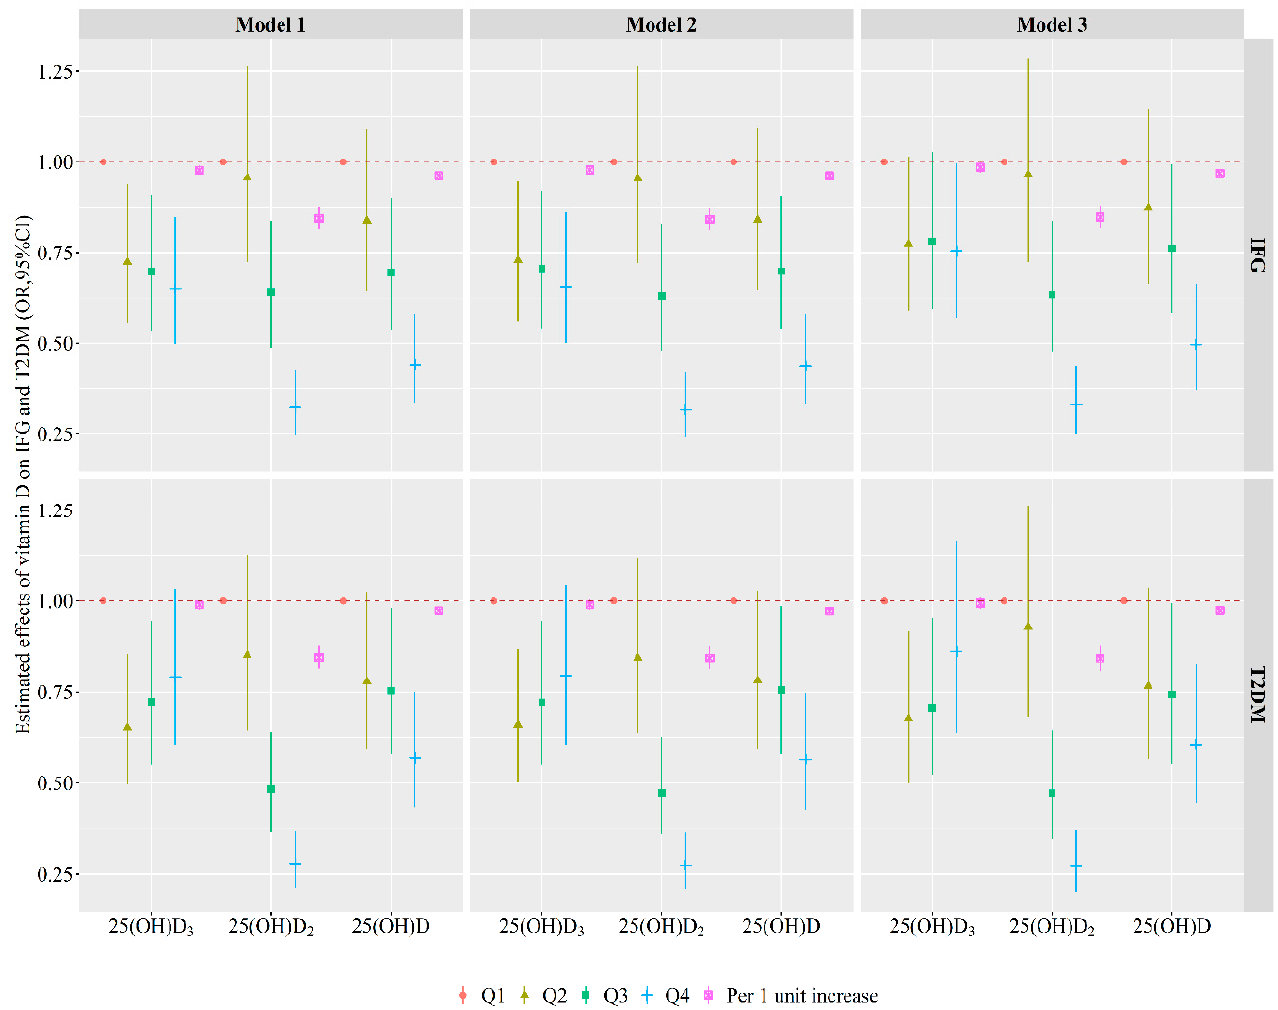
Figure 1. Associations of serum 25(OH)D 3 , 25(OH)D 2 , and total 25(OH)D levels with IFG and T2DM. Model 1: no adjust; Model 2: adjusted for smoking status, alcohol intake, physical activity, average monthly individual income, level of education; Model 3: model 2 + BMI, SBP, PP, TC, TG, HDL-C, LDL-C and family history of T2DM. Abbreviations: IFG, impaired fasting glucose; OR , odds ratio; Q1, the first/lowest quartile; Q2, the second quartile; Q3, the third quartile; Q4, the